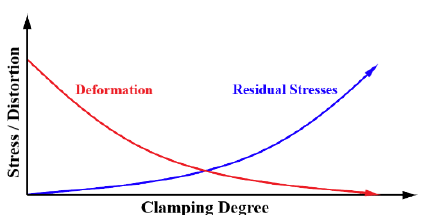
Figure 1. Relationship between the clamping degree and the level of distortion as well as the effect on residual stresses.